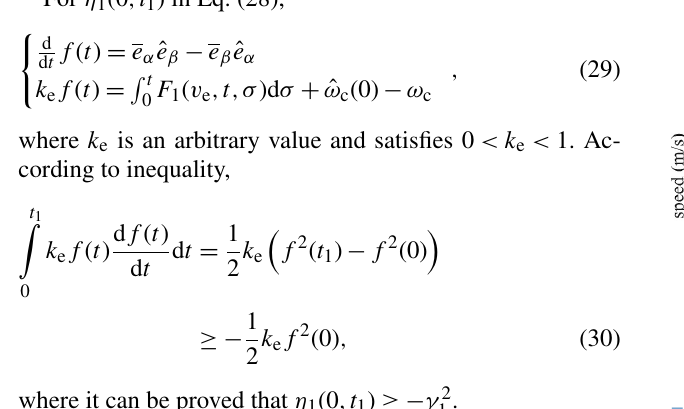
Figure 12. Speed waveform of PI